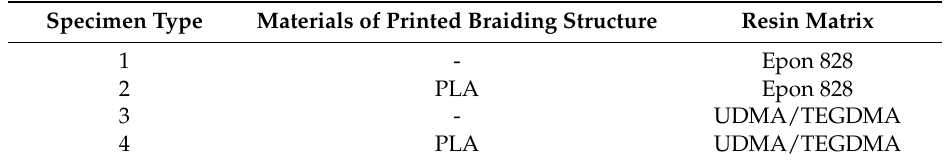
Table 4. Specimen types and materials.